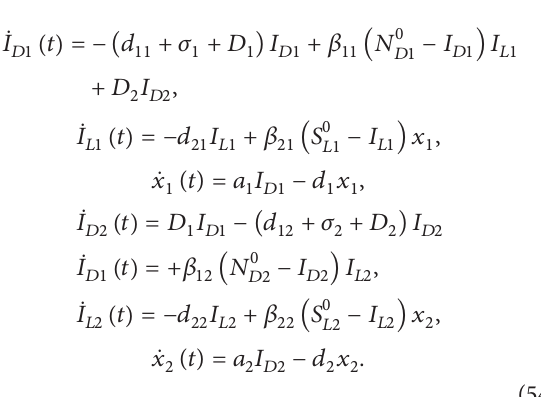
𝑆 0 − 𝑆 (𝑡) , 𝑖 = 1, 2 , respectively, and the model (2) 𝐿𝑖 𝐿𝑖